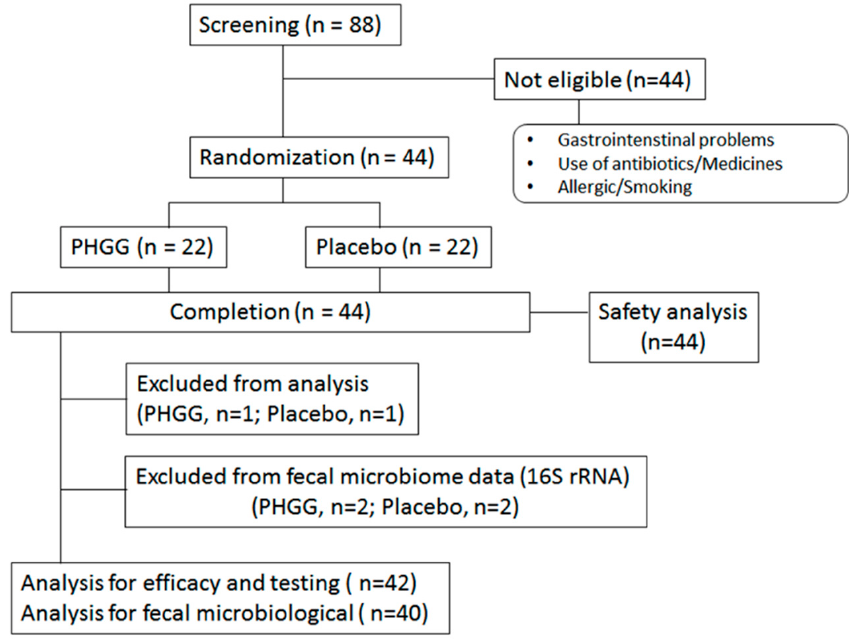
Figure 2. Flow chart of study participants.